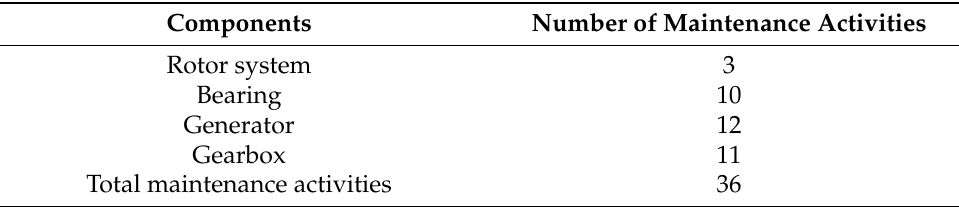
Table 8. The optimal total number of maintenance activities for the whole system for 240 months.